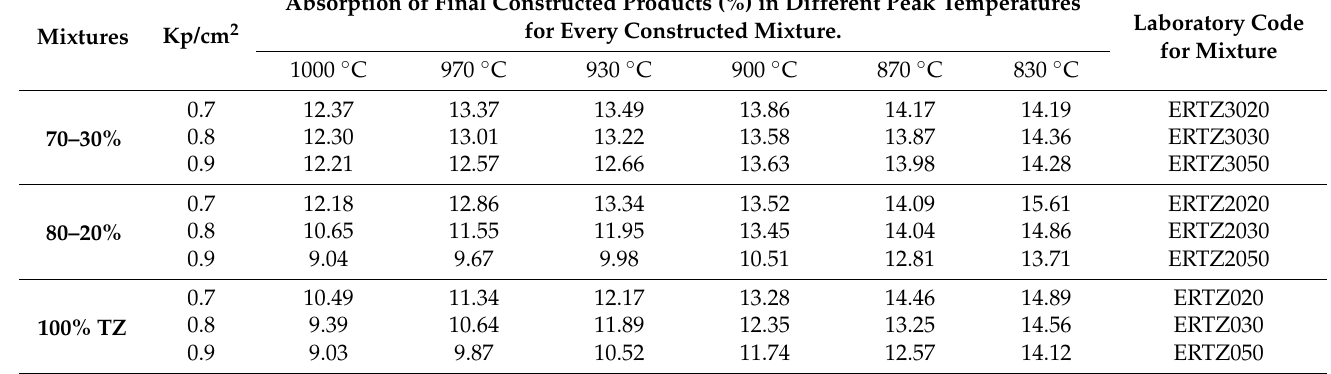
Table 8. Absorption for all constructed mixtures at 6 different